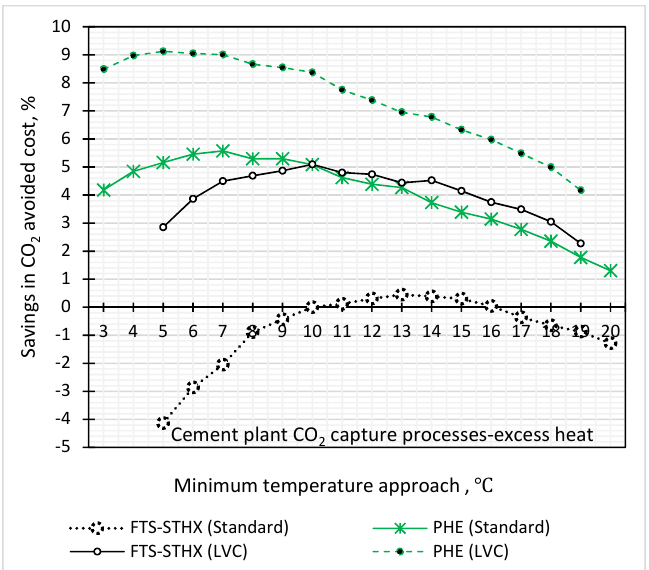
Figure 18. Cost reduction analysis at different ∆ T min for different heat exchanger types compared with FTS–STHX of ∆ T min = 10 ◦ C, in waste heat utilisation scenario. Table 16. CO 2 avoided cost and emissions reduction performances of FTS-STHX and PHE with and without available waste heat for 50% CO 2 capture from Brevik cement plant’s flue gas. The cost reduction impact of having steam supply that is sufficient for up to 50% CO 2 capture and its impact on the actual CO 2 emissions reduction compared with a reference case (the original base case) of a standard CO 2 capture having FTS-STHX with ∆ T min of 10 ◦ C are presented in Table 16. Table 16 is a summary of all the 90% CO 2 capture from the cement plant’s flue gas based on CO 2 avoided cost. The results indicate that if the lean vapour compression configuration is implemented with PHE as the lean MEA cooler, DCC circulation water cooler and as the lean/rich heat exchanger with a ∆ T min of 5 ◦ C, and steam can be successfully provided for up to 50% capture, then 10.4% more CO 2